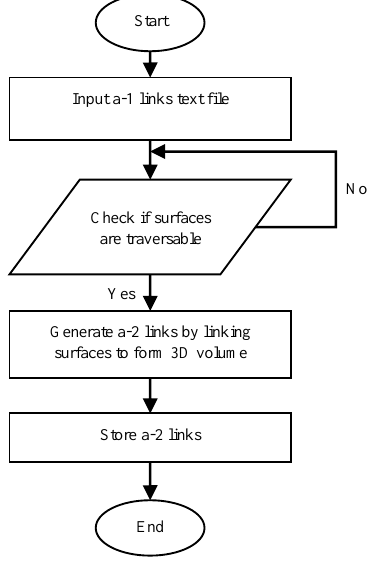
Figure 8. Flowchart for generating a-2 links